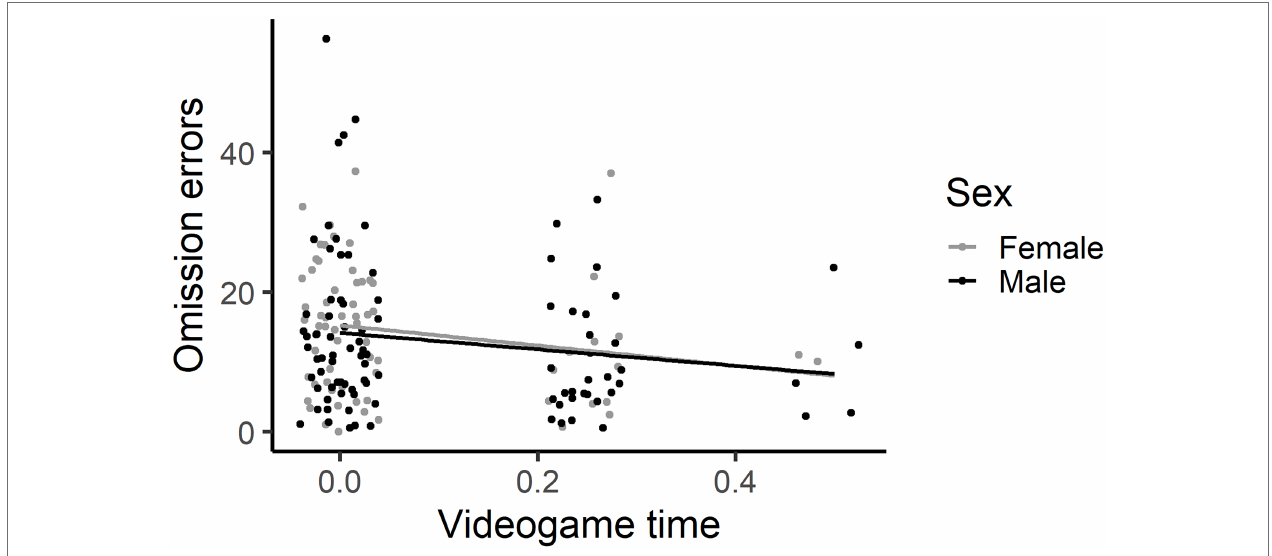
FIGURE 4 | The more time spent playing videogames, the less omission errors made. This graph has each individual’s data point shown, using